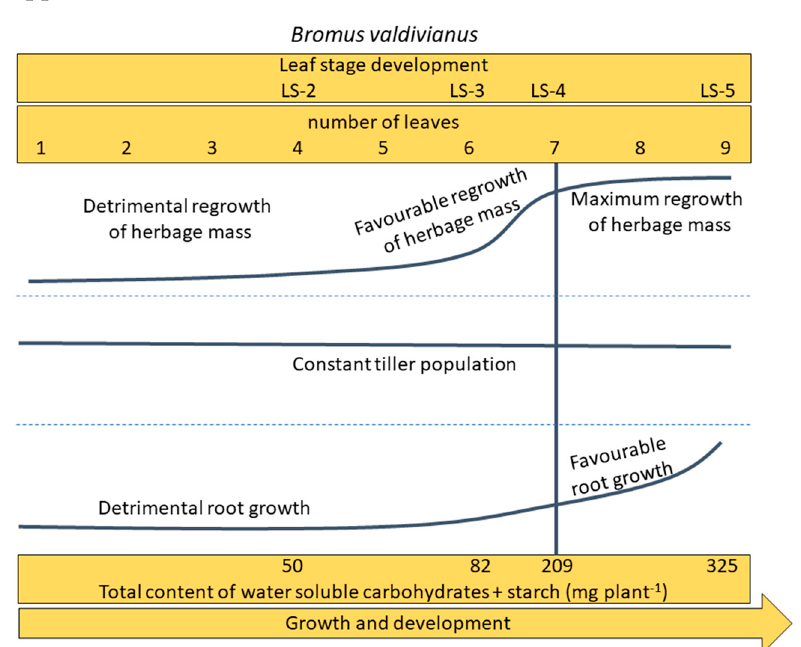
Figure A1. Effect of defoliation frequency, based on leaf stage development or number of leaves, on Bromus valdivianus total accumulation of non-structural carbohydrate reserves (water-soluble carbohydrates + starch) and the following repercussions on regrowth, evaluated through tiller population, herbage mass and root growth.